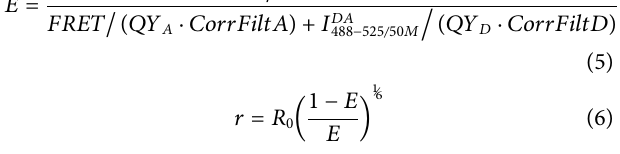
FIGURE 1 | surface interactions, in contrast to supported bilayers where the channels are in close proximity to the supporting surface. The fl uorescence and ionic current are simultaneously measured as described in the text. (E) . Open probability of KcsA-E71A-H124C as a function of pH for two different lipid compositions. Single-channel recordings did not reveal signi fi cant changes in the pH dependence of the open probability between DPhPC/ decane and 22:1 PC-18:1 PG/decane bilayers (N > 3 for each condition). (F) , Example of KcsA channels in planar lipid bilayer (DPhPC/decane). (G) ,